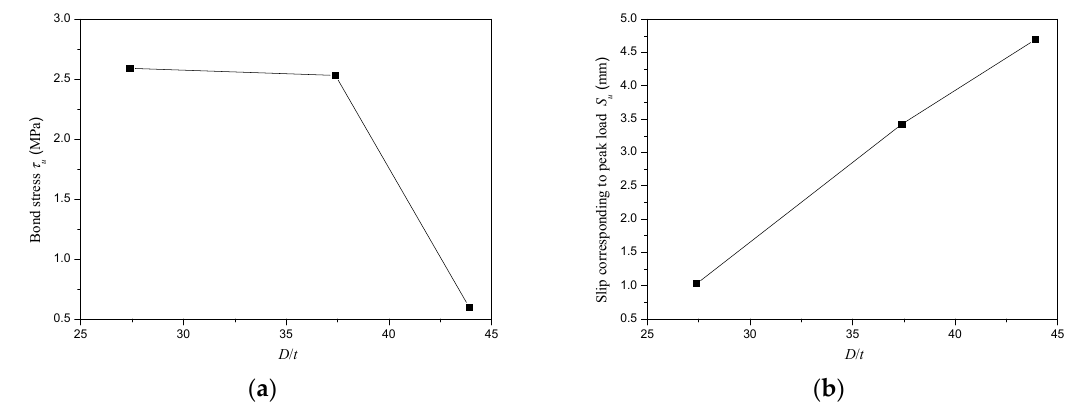
Figure 10. Variation of bond stress ( τ u ) and slip corresponding to peak load ( S u ) with D / t ratio. ( a ) Bond stress ( τ u ); ( b ) Slip corresponding to peak load ( S u ).